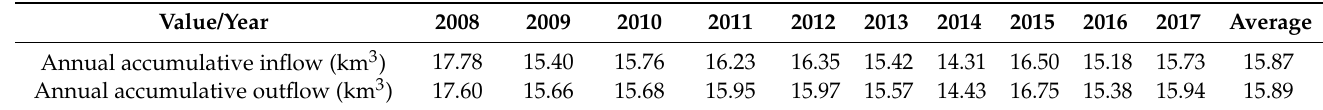
Table 3. Calculated water transport through the Strait of Baltiysk.